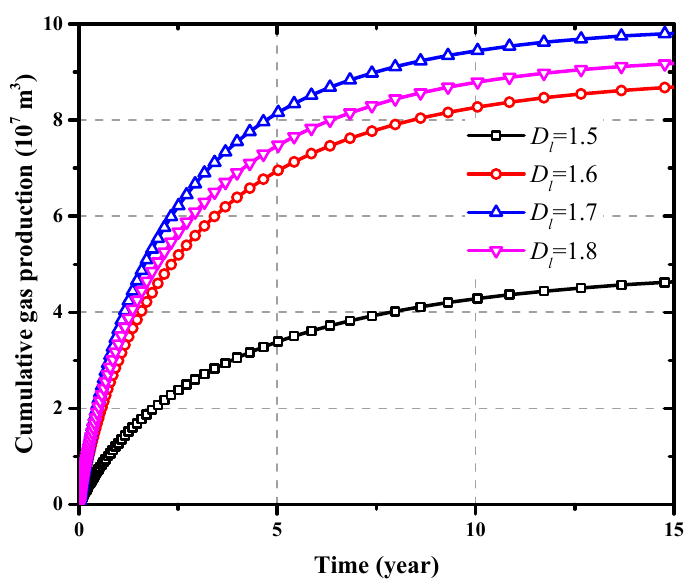
Figure 8. Gas production rate from the fracture network with different length fractal dimensions.